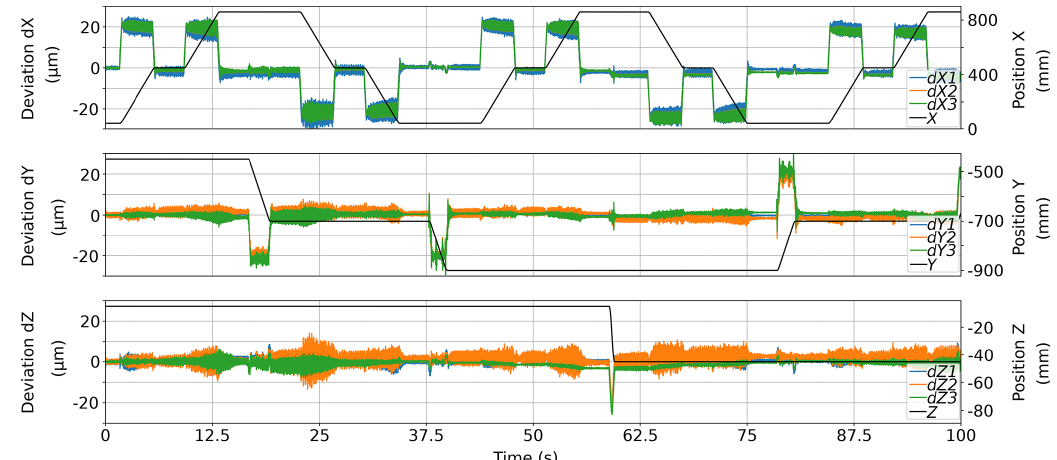
Figure 2. Relative coordinate deviation between multilateration and CMM reference for each retroreflector. The primary y axis indicates the relative deviation, while the secondary y axis indicates the nominal position of the CMM